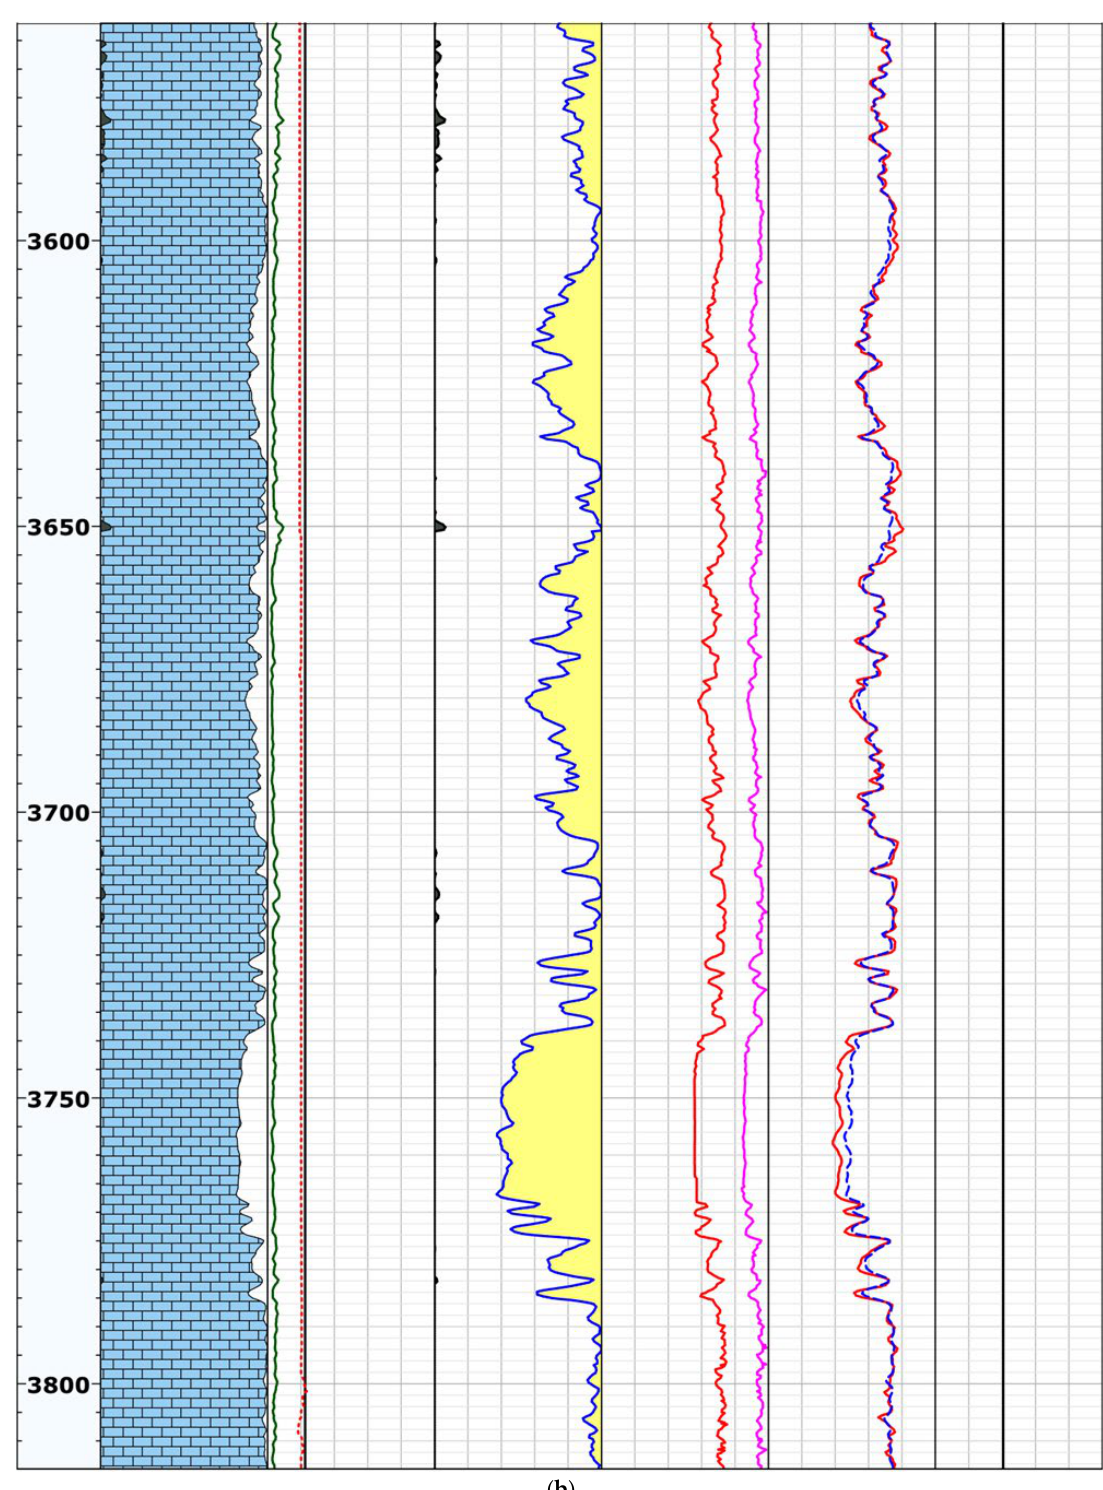
Figure 3. ( a )Input petrophysical well data for depth interval of 3370–3570 m (11,057 to 11,713 ft). ( b ) Input petrophysical well data for depth interval of 3570–3815 m (11,713 to 12,517 ft). Legend: MD—measured depth; Az—azimuth; Inc—inclination angle; DEG—degree; CGR—compensated gamma ray; GAPI—gamma ray unit; Cal—caliper; BS—bit size; IN—inch; DTC—acoustic compres- sional slowness; DTS—acoustic shear slowness; US/FT—micro-second per foot; NPHI—neutron porosity; V/V—(pore) volume to (bulk) volume ratio; RHOB—bulk density, G/CC—gram per cubic centimeter, MW—mud weight, ppg—pounds per